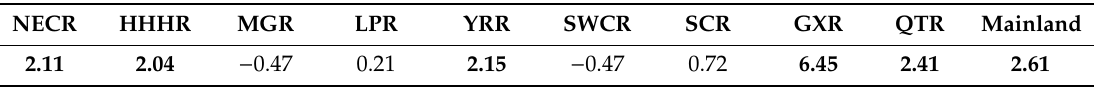
Table 3. The annual drought trends (Z-value) in China and nine regions during 1961 to 2018. NECR HHHR MGR LPR YRR